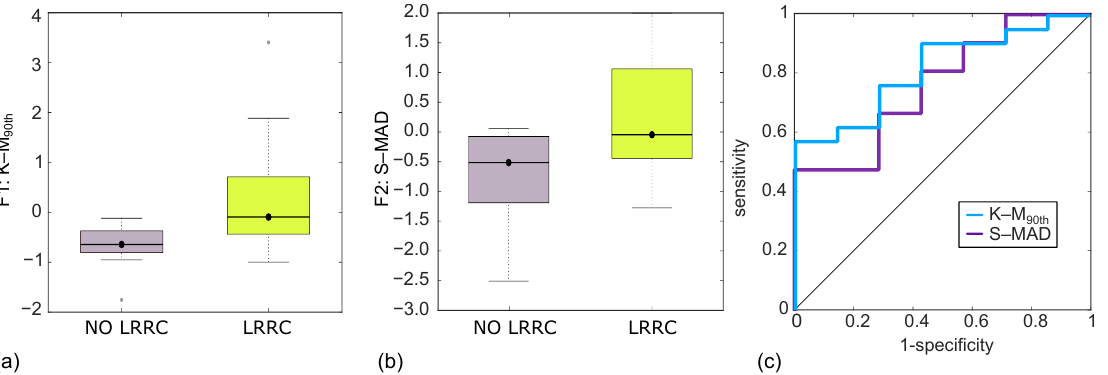
Figure 2. Boxplots of the discrimination achieved by CT imaging, between NO LRRC and LRRC groups, through K-M 90 th ( a ) and S-MAD ( b ), and their ROC curve ( c ), yielding AUC = 0.82 (95% C.I. 0.50–0.97), SN = 57%, and SP = 100%, with I = 0.57 for K-M 90 th and AUC = 0.76 (95% C.I. 0.53–0.97), SN = 67%, and SP = 71%, with I = 0.38 for